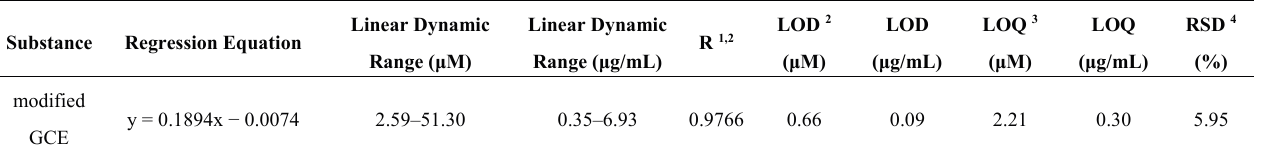
Table 4. Analytical parameters of electrochemical detection of GCE modified by CO-ttc-NAF, n =